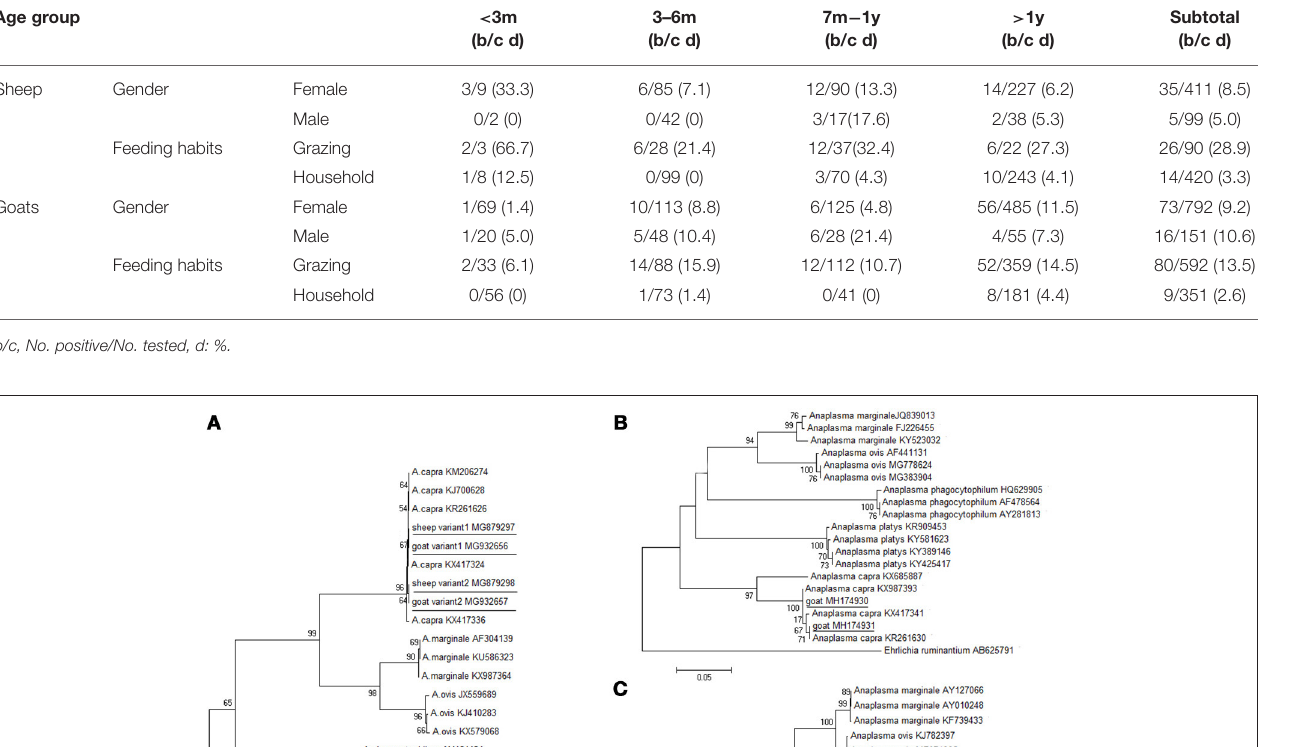
proposed that A. capra might infect endothelial cells in vivo